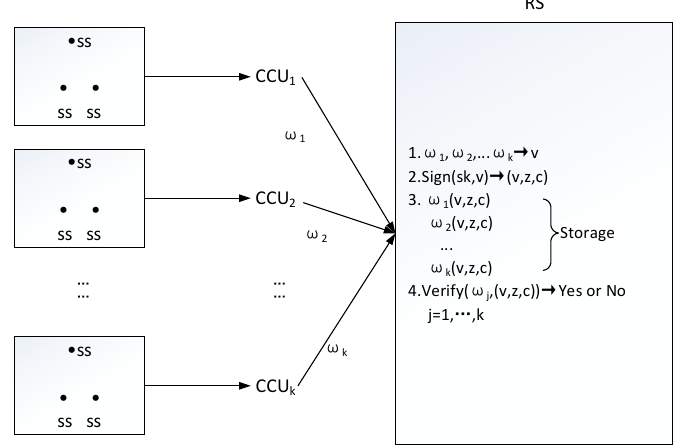
Figure 3. Data Flow Diagram in Wireless Body Sensor